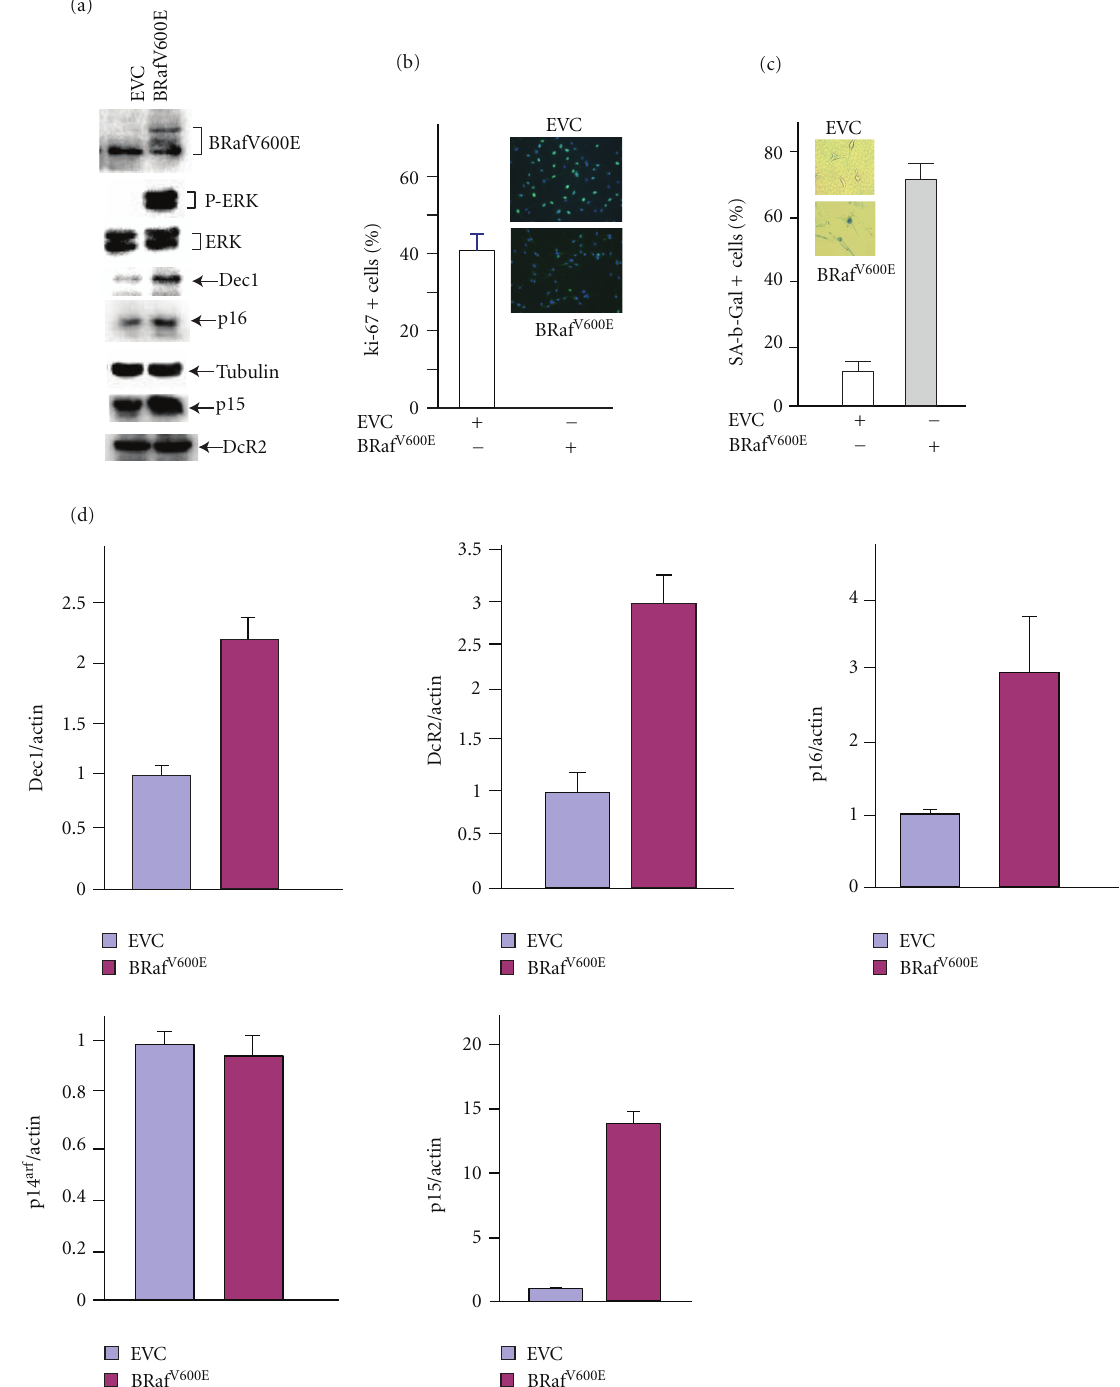
Figure 1: Melanocytes were infected with control retroviral empty vector (EVC) or with a vector expressing BRaf V600E . Four days after infection, cells were harvested for (a) immunoblotting with specific Abs as indicated or (d) total RNA. The expression levels of the indicated senescence markers in BRaf V600E expressing or control cells were quantified by qRT-PCR and normalized to the level of b-actin. The values represent the means and standard deviation from three independent experiments. Cells were also isolated 4 days after infection, fixed, and stained for (b) ki-67 or (c) SA- β -Gal activity. Insets: representative fields are shown for control EVC and B-Raf V600E expressing cells stained with ki-67 Ab or positive for SA- β -Gal